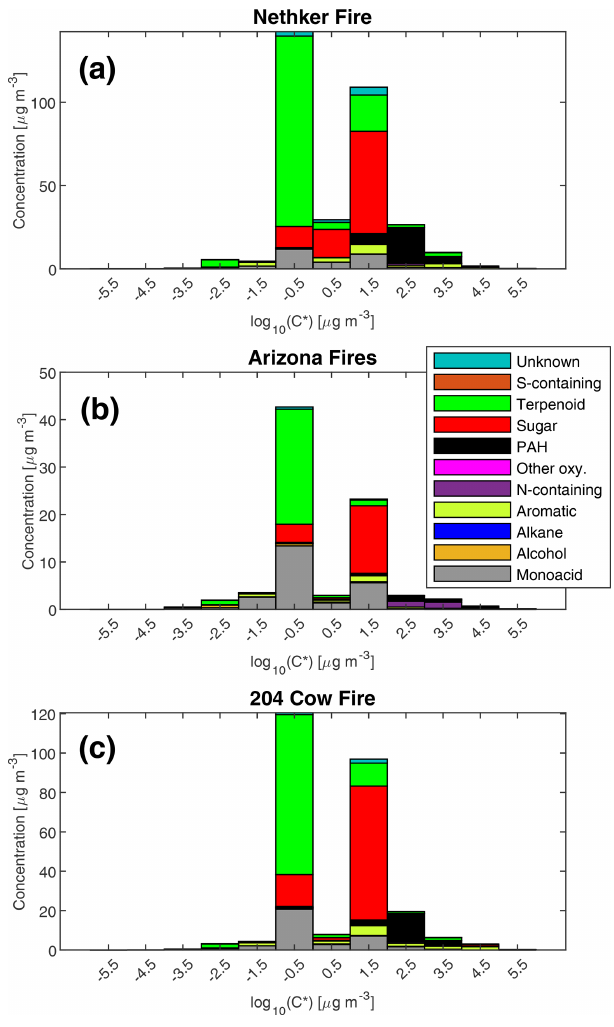
Figure 4. Mass distribution of speciated compounds in different effective saturation concentration bins. As an example, the bin cen- tered at − 0.5 includes compounds with log 10 ( C ∗ ) between − 1 and 1µgm − 3 . Panel (a) is for the most heavily loaded sample collected near the Nethker Fire (OC = 352µgm − 3 ). Panel (b) is for the most heavily loaded sample collected near the Arizona Ikes and Castle Fires (OC = 138µgm − 3 ). Panel (c) is for the most heavily loaded sample collected near the 204 Cow Fire (OC = 260µgm − 3 ). N = 1 for each